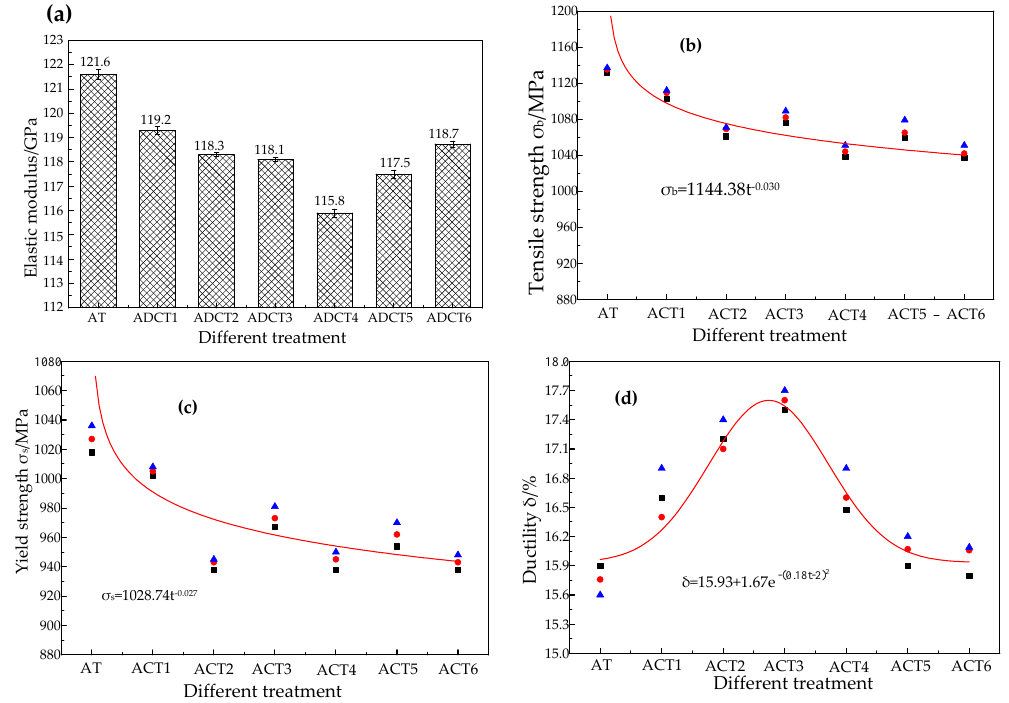
Figure 6. Changes of tensile test: ( a ) elastic modulus; ( b ) tensile strength; ( c ) yield strength; ( d ) ductility.